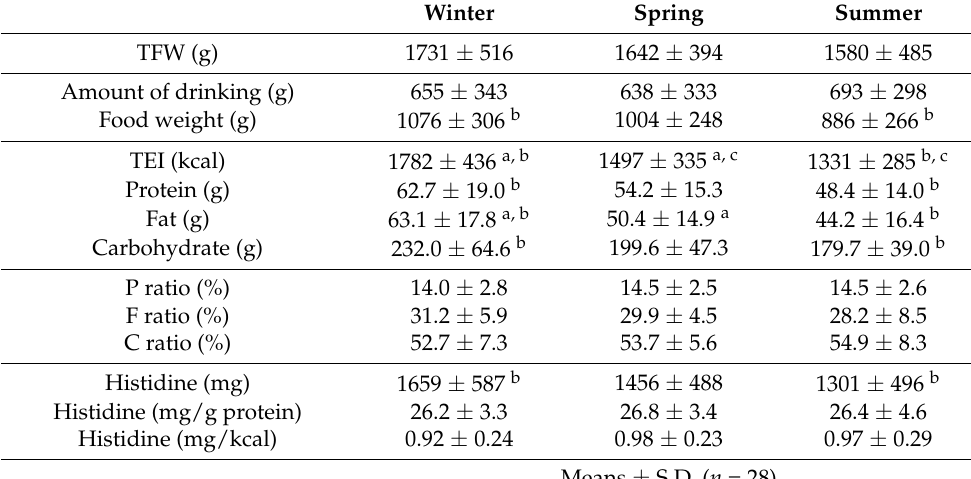
Table 3. Seasonal changes in food weight, energy, and nutrient